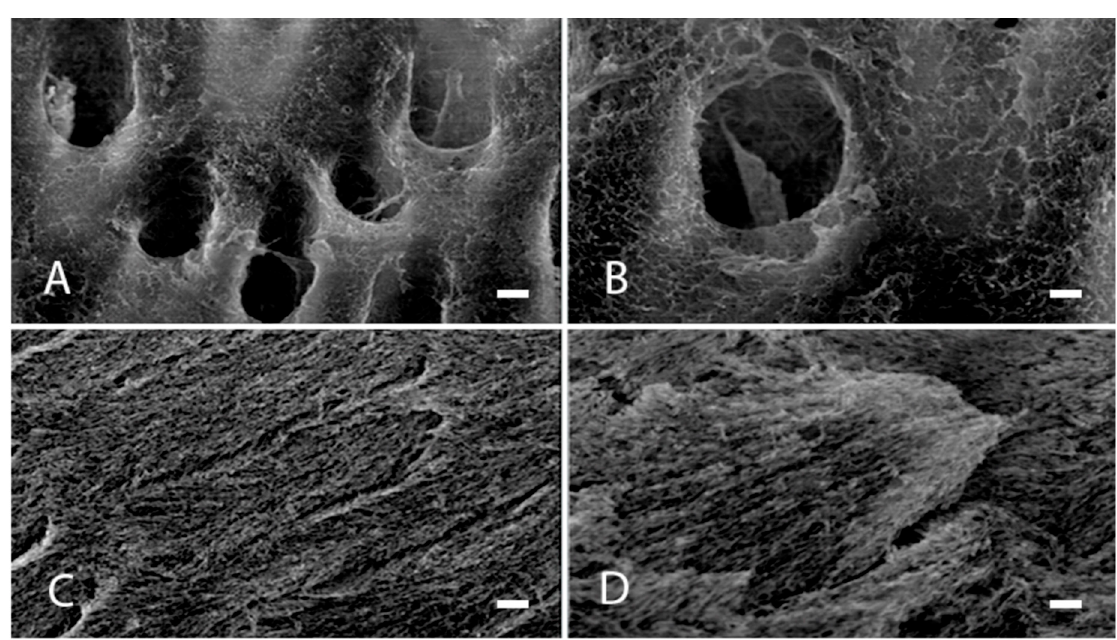
Figure 1. SEM analysis of enamel and dentin from healthy donors. ( A ): Intertubular tissue; ( B ): Collagen fibers; ( C , D ): Enamel with rare micropores and abundant prisms.